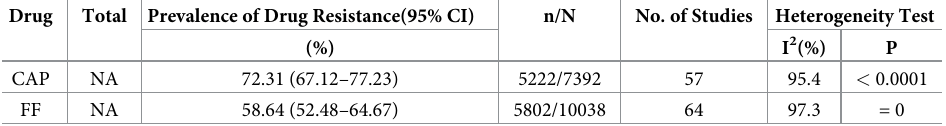
Table 1. The overall prevalence of the Chloramphenicol/ Florfenicol resistance in mainland China.